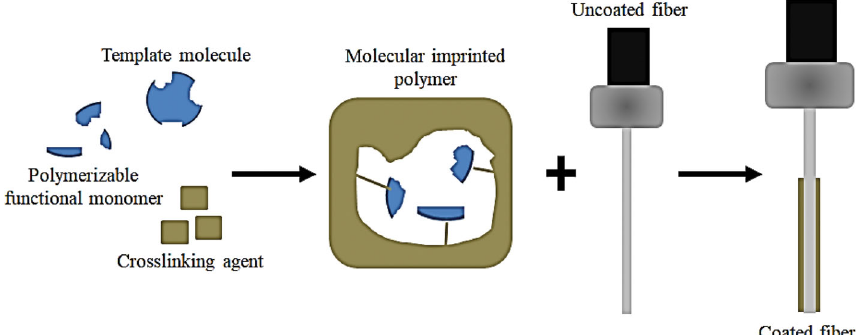
Figure 3: Fabrication procedure for MIPs and coating of an SPME